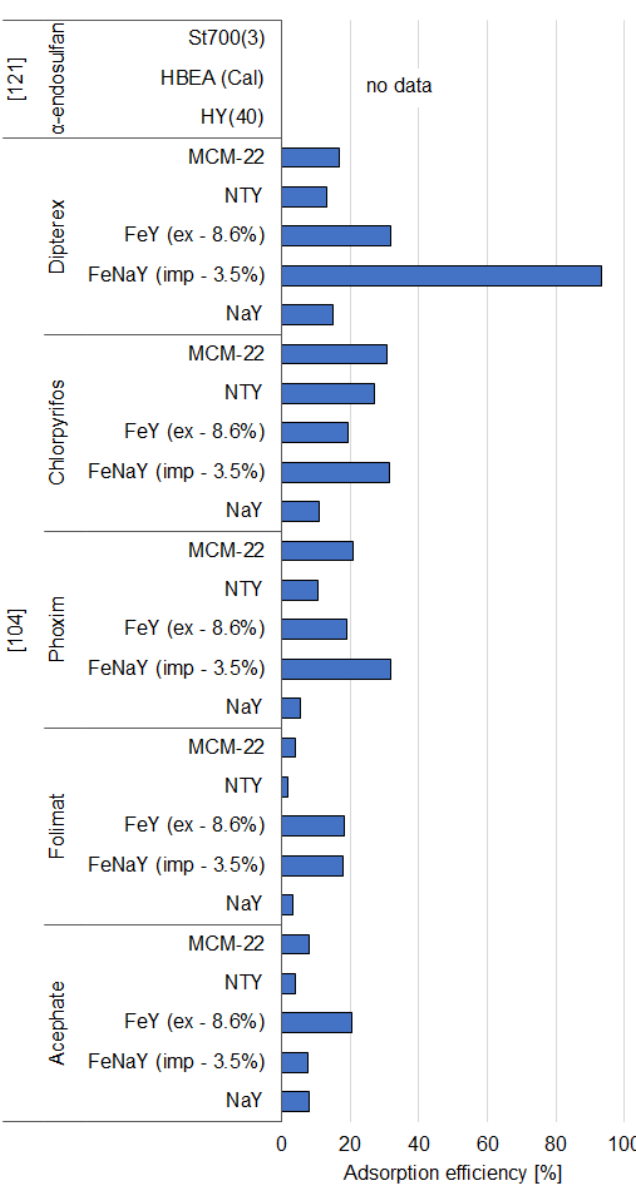
Figure 5. Effectiveness of removal of organochlorine and organophosphorus pesticides by synthetic zeolites.